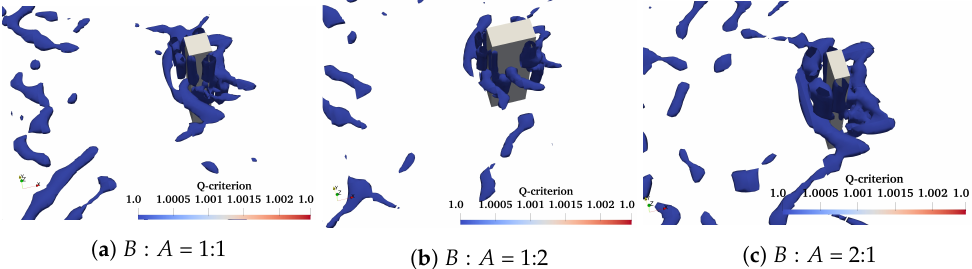
Figure 16. Isosurfaces visualizing turbulent structures for Q = 1 s − 2 , KC number = 5.75, and wave current parameter ( U cw ) = 0.4 with different aspect ratios of the rectangular pile.